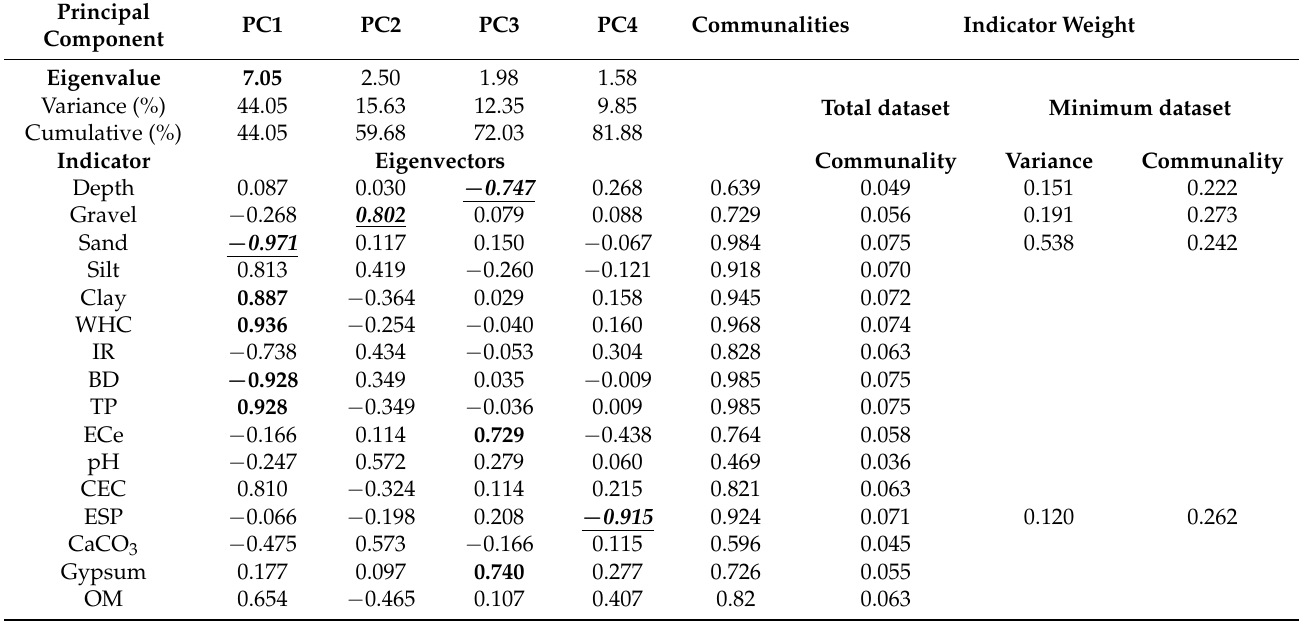
Table 4. Results of the principal component analysis (PCA) for soil indicators in Dakhla Oasis.